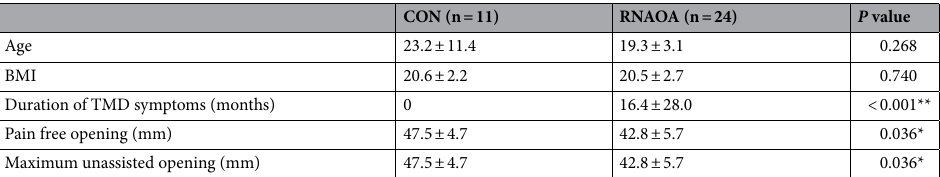
Table 1. Demographic features and TMD characteristics of participants. Descriptive values are shown as mean ± SD. Data obtained from Mann–Whitney U tests. *P < 0.05, ** P < 0.001 by Mann–Whitney U